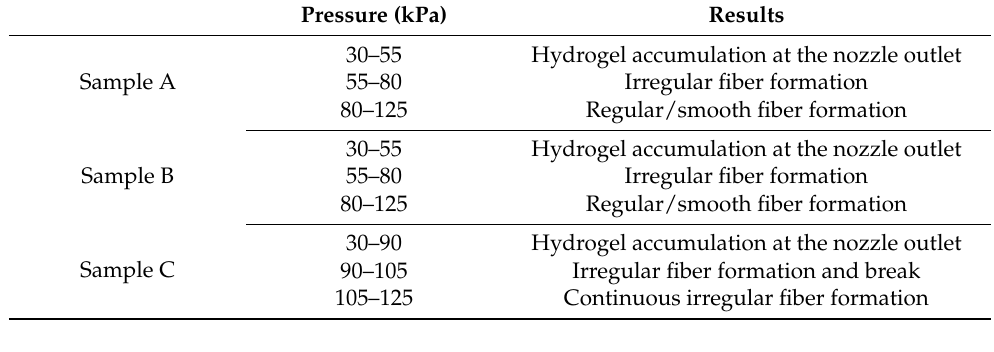
Table 1. Drop or fiber formation test results.